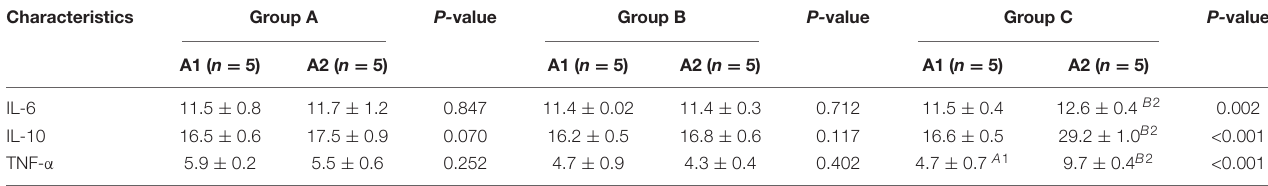
TABLE 2 | The results of blood analysis performed for rats of the three groups. Characteristics Group A P- value Group